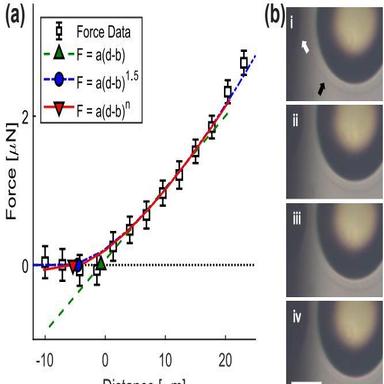
(a) Representative force-displacement data showing the contact point identified by different fitting functions. A single symbol is plotted with each fitting function to show the intersection with the axis (the contact point). (b) Images of the microcapsule and compressing surface corresponding to the 2nd (i), 3rd (ii), 4th (iii), and 5th (iv) data points in the compression. Note the transparent shell (black arrow) and the reflection of the core (white arrow) on the compressing surface. (Scale bar: 50μm).